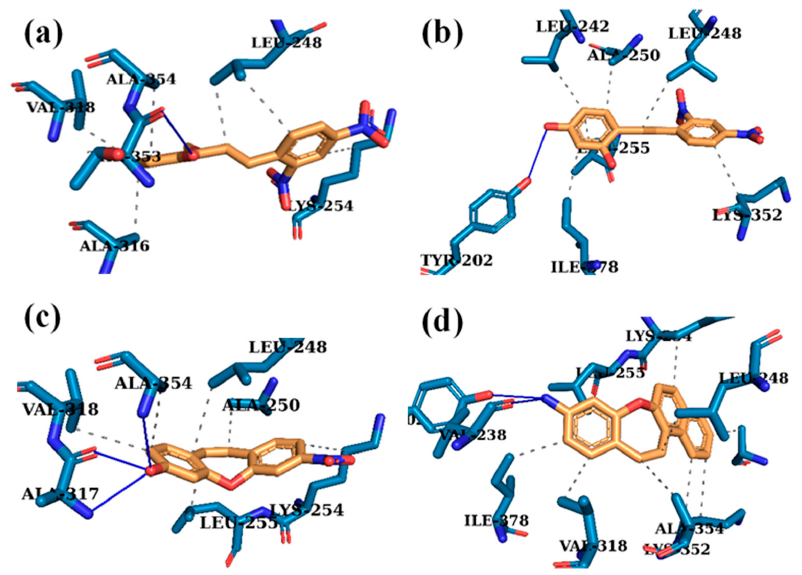
Figure 5. Stick representation of the top-ranked docking poses (orange) and predicted interactions of compounds ( a ) 1d , ( b ) 1i , ( c ) 2i , and ( d ) 3h with αβ -tubulin (PDB code: 1SA0). For clarity, only amino acids interacting with ligands are shown. Blue lines represent hydrogen bond interactions; dashed gray lines represent hydrophobic interactions.